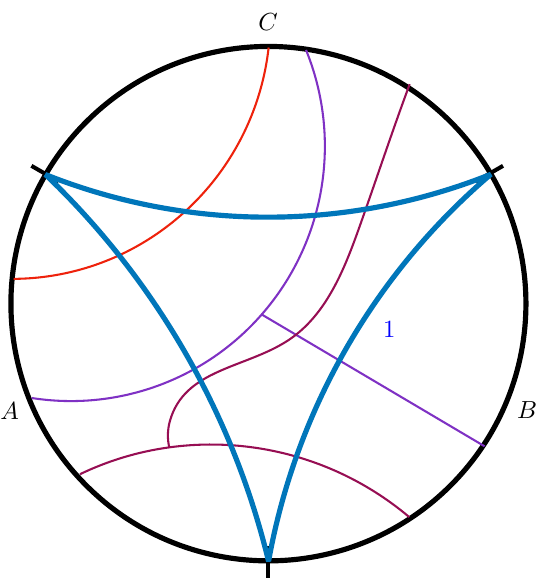
) crosses a total i